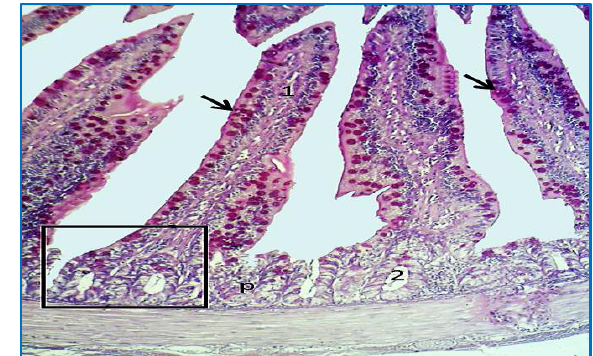
F igure, 11: duodenum of bulbul shows the goblet cells within villi showed positive reaction to PAS stain (arrows) and the negative reaction within crypts (2), lamina propria (p).